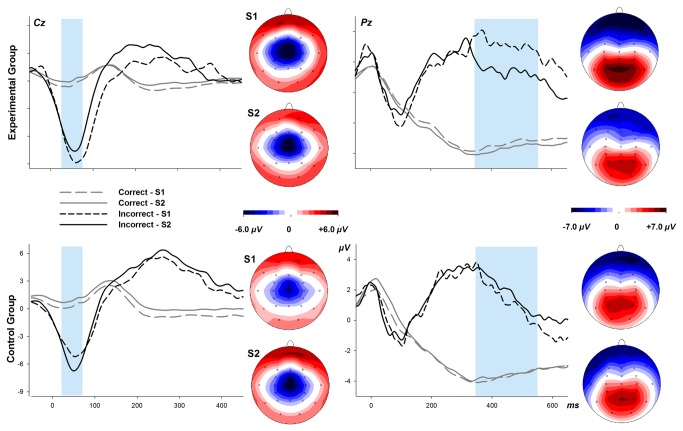
Response-synchronized ERPs from the Simon task.Left panel: ERPs at electrode Cz, superimposed for correct and incorrect (corr., incorr.) responses and pre-meal and post-meal sessions (S1, S2) and for the Experimental and Control group. Topographies of the Ne as the difference between incorrect and correct responses are depicted to the right of the waveforms. Right panel: Same as left panel but for electrode Pz (please note changes in voltage and time scales). Topographies of error positivities (350-550 ms) are shown to the right of the waveforms.